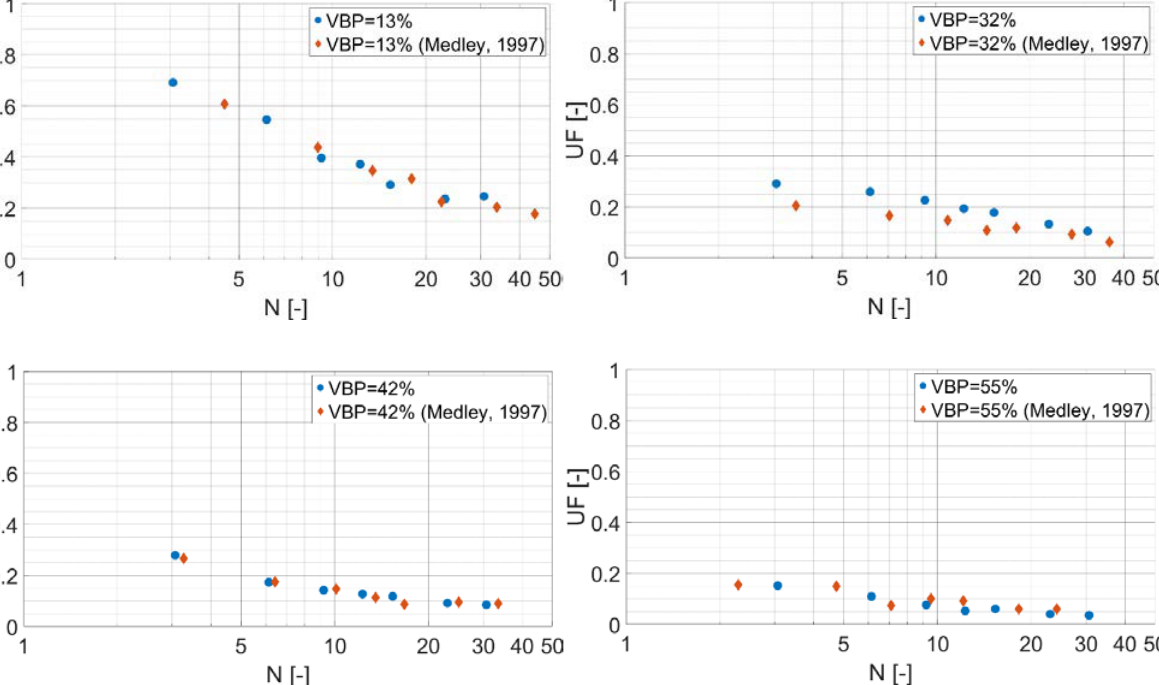
Figure 6. Uncertainty in the VBP estimate from LBPs as a function of the total sampling length, N, obtained in this research. Medley’s (1997) [43] results are also shown by way of comparison.